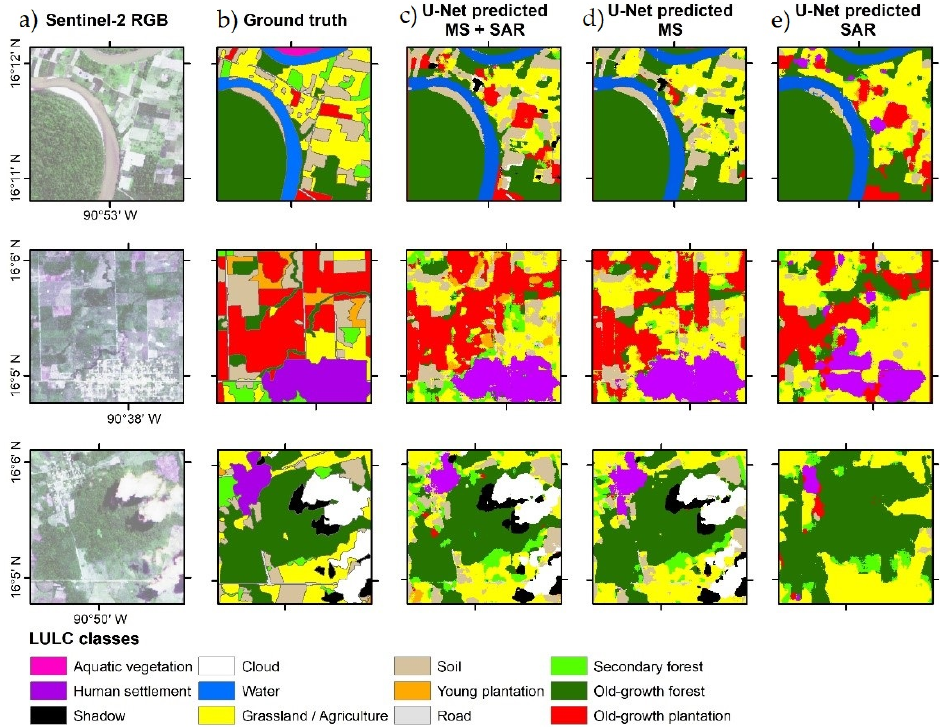
Figure 4. Evaluation of the U-net predictions in three different areas of the validation set. ( a ) RGB Sentinel-2 image, ( b ) Manually classified areas, ( c ) U-net prediction with multispectral (MS) + synthetic aperture radar (SAR) bands, ( d ) U-net prediction with MS, ( e ) U-net prediction with SAR.